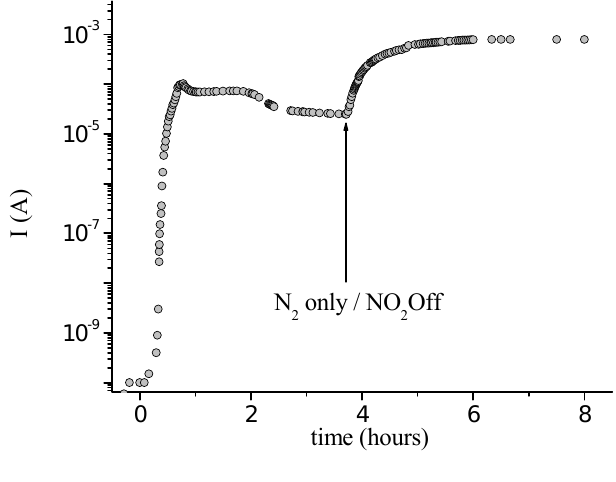
Figure 4. Variation of the current intensity of 50 nm thick TiPc interdigitated electrode as a function of time when exposed to a mixture of NO (20 nmol/s and 180 nmol/s, respectively) and then to pure N + ). (b) Equilibrium between the monocationic (TiPc monocationic species (TiPc 2 bicationic (TiPc 2++ ) species. (c) Introduction of pure N logarithmic scale for better appreciation of the trend of the curve. Reproduced with the permission from reference